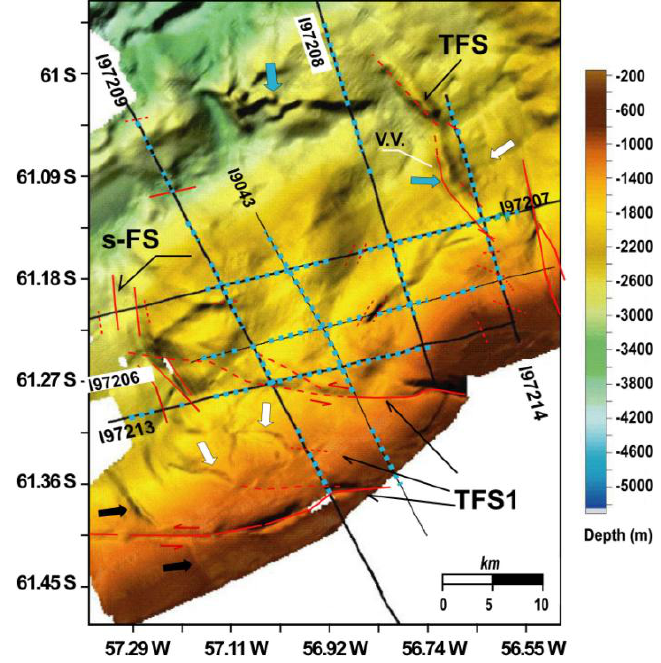
Figure 4. Shaded relief integrating seismic profile interpretations and morpho-bathymetry information. The recognized fault systems are indicated with thick red lines; minor faults and fractures are indicated with dashed red lines. White arrows indicate slumps; light blue arrows indicate the recognized mud volcanoes; and black thick arrows indicate a submarine canyon. Anticline and sharp folds are indicated with green symbol. s-FS: secondary Fault System; TFS: Thrust Fault System; V.V.: Volcano